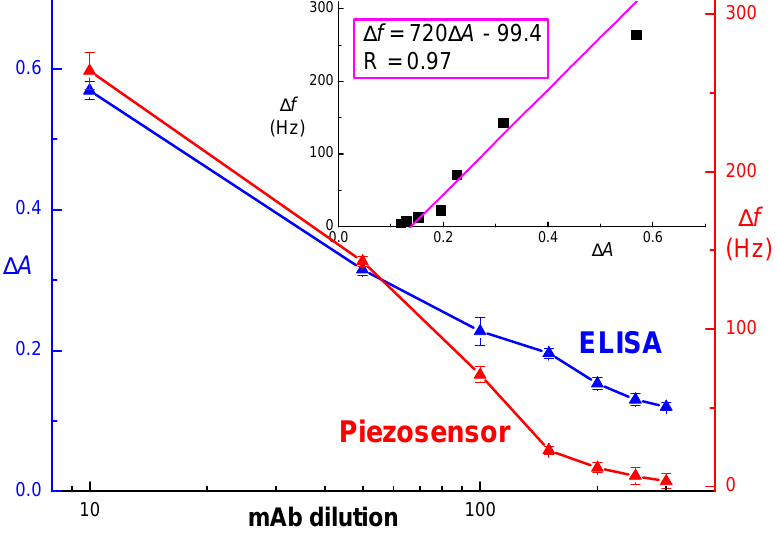
Fig.2. Dilution curves (scale from 1:10 to 1:300) for the monoclonal antibody 4H3B9D3 obtained using the indirect ELISA and the piezoelectric immunosensor. The ELISA microplates were coated with F. tularensis LPS, and 100 m l of sample was used for testing. The secondary anti mouse Ab labeled with peroxidase was the tracer and the response is presented as absorbance of the enzyme product corrected for the blank value (blue symbols). Similar experiment was carried out using the piezoelectric sensor covalently modified with LPS, response (red symbols) indicates the change of frequency after the flow of 100 µl sample. The inset graph shows the correlation between the values from ELISA and immunosensor including parameters of the linear regression. The error bars indicate estimated standard deviations (n =